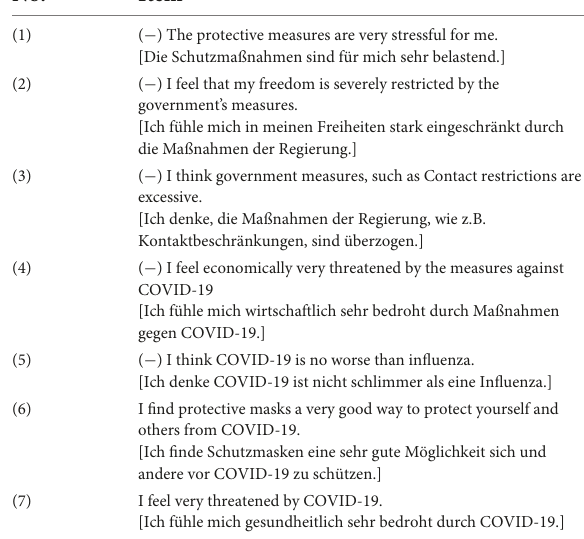
TABLE 1 Items for attitude toward measures against COVID-19 (original German terms in